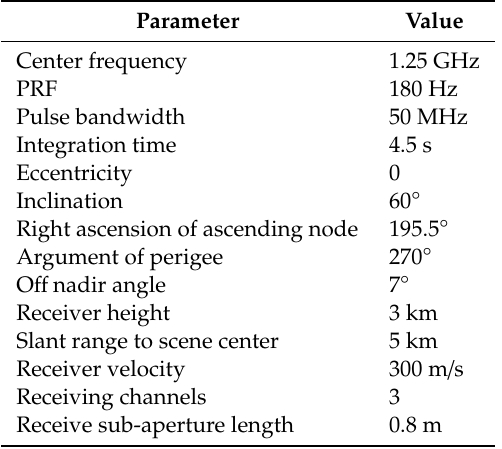
Table 1. Designed parameters in GEO-SA-BiSAR for